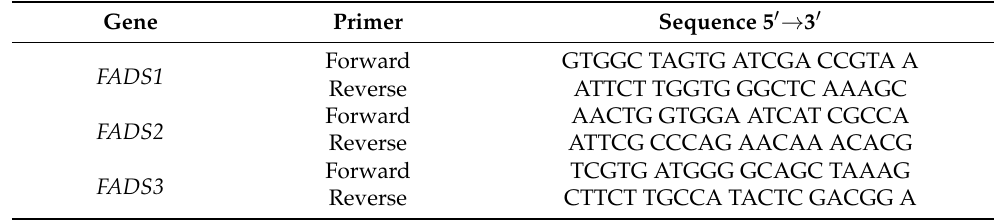
Table 1. Primer sequences of FADS genes used for quantitative RT-PCR amplification.